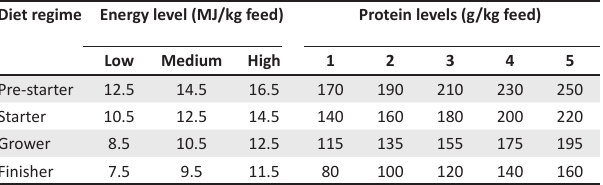
TABLE 1: A representation of the energy and protein levels for the 15 feeding regimes with varying levels of energy and protein in the diet, formulated for the pre-starter, starter, grower and finisher phases of ostrich chicks.